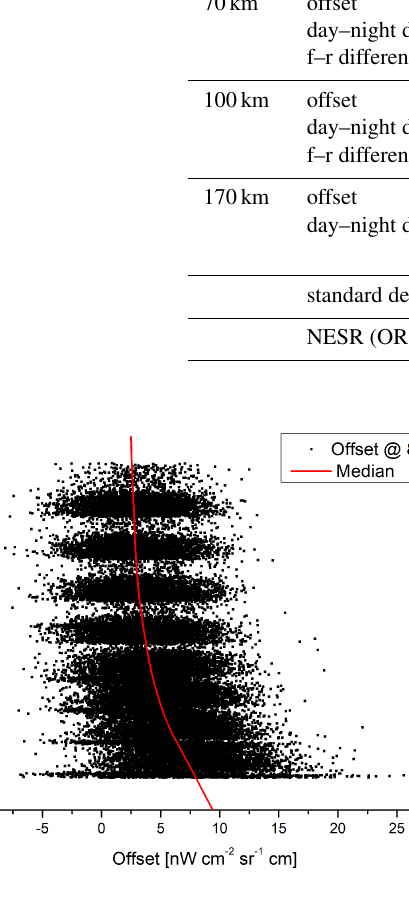
Figure 15. Offset determined from calibrated spectra in an altitude range of 33 to 63km around 832cm − 1